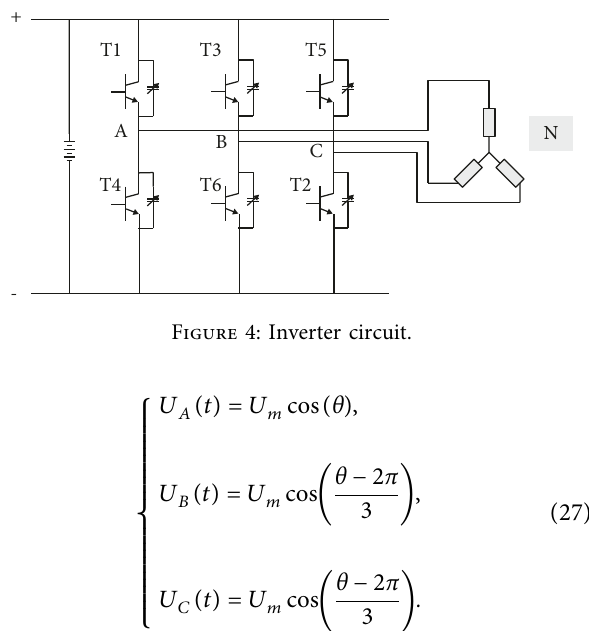
Figure 3: Park transformation relationship diagram.